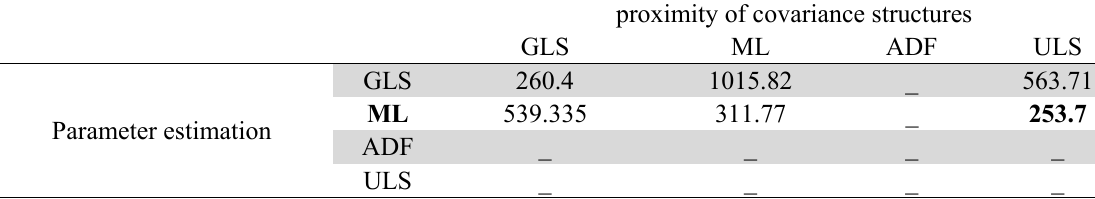
The results of Bootstrap selection procedure